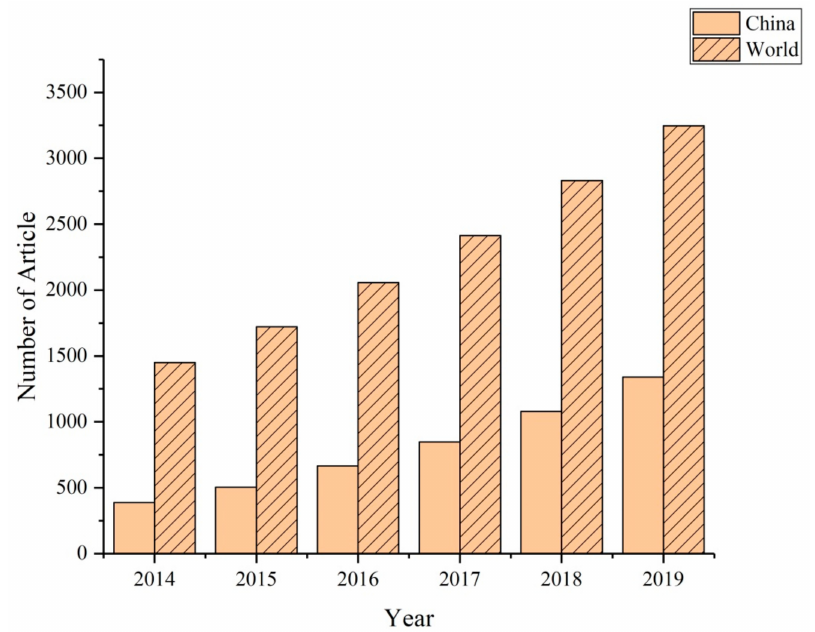
Figure 4. Number of anammox-related studies published in China and around the world (Data source: Web of Science).